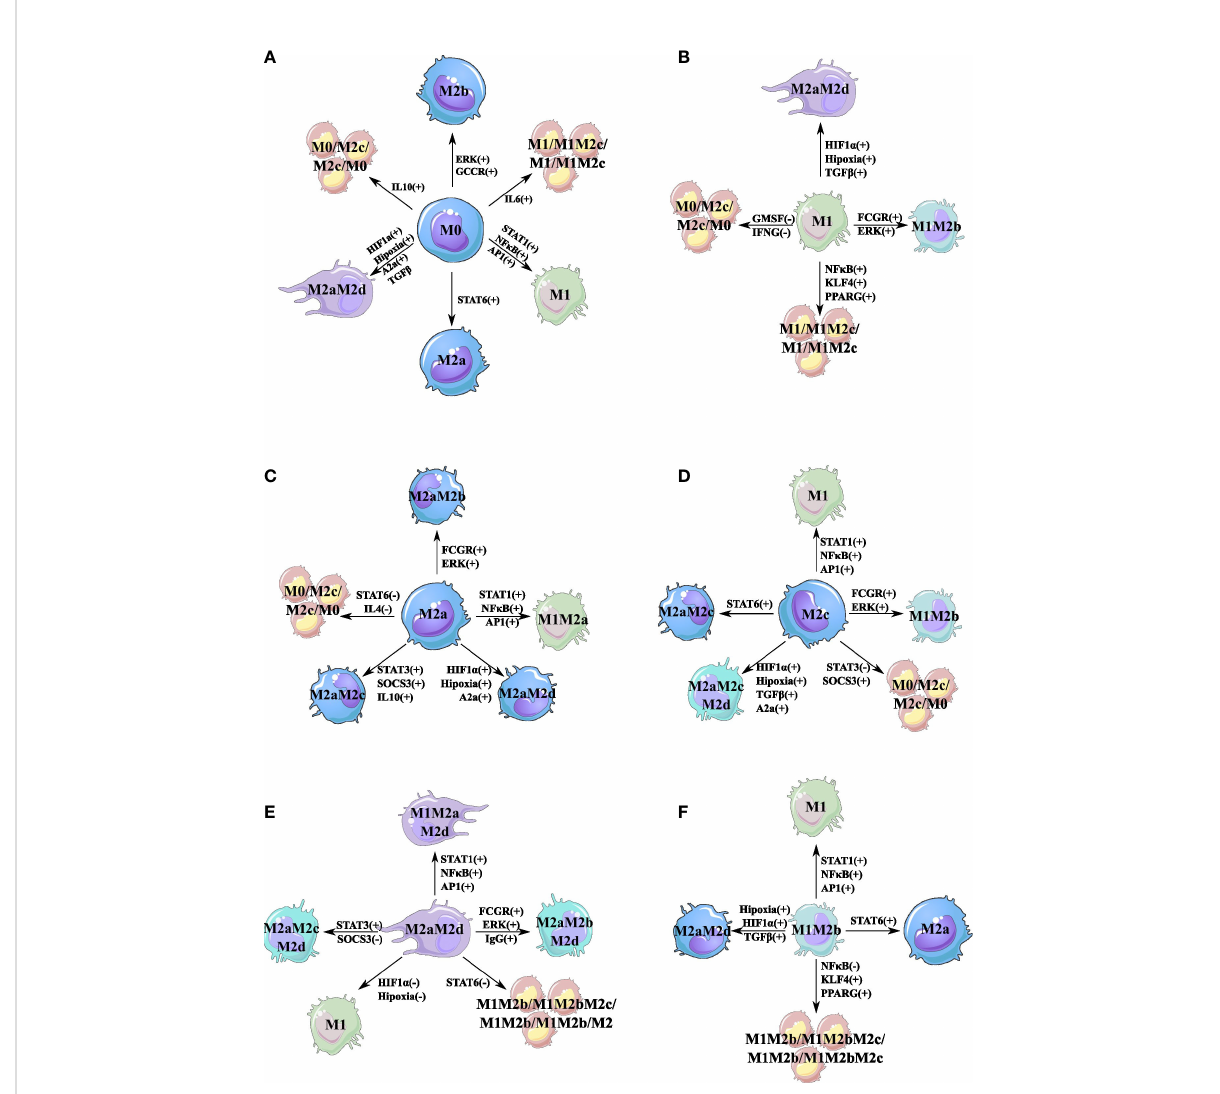
FIGURE 2 Cell fate map of the macrophage polarization. For each attractor obtained, we changed the node ’ s value and maintained this perturbation until an attractor was reached. If the attractor transit to another phenotype, we represent this transition with a line linking the original phenotype with the new phenotype obtained by the perturbation. A single perturbation plus sign (+) means that the node was turned off (0), and we turn it on (1). Meanwhile, a minus sign ( − ) means that the perturbation was on (1), and we turned it off (0). (A) Cell fate map for monocyte (M0). (B) Cell fate map for M1 macrophage. (C) Cell fate map for M2a macrophage. (D) Cell fate map for M2c macrophage. (E) Cell fate map for M2aM2d macrophage. (F) Cell fate map for M1M2b macrophage. Colors represent different states (attractors) of macrophage